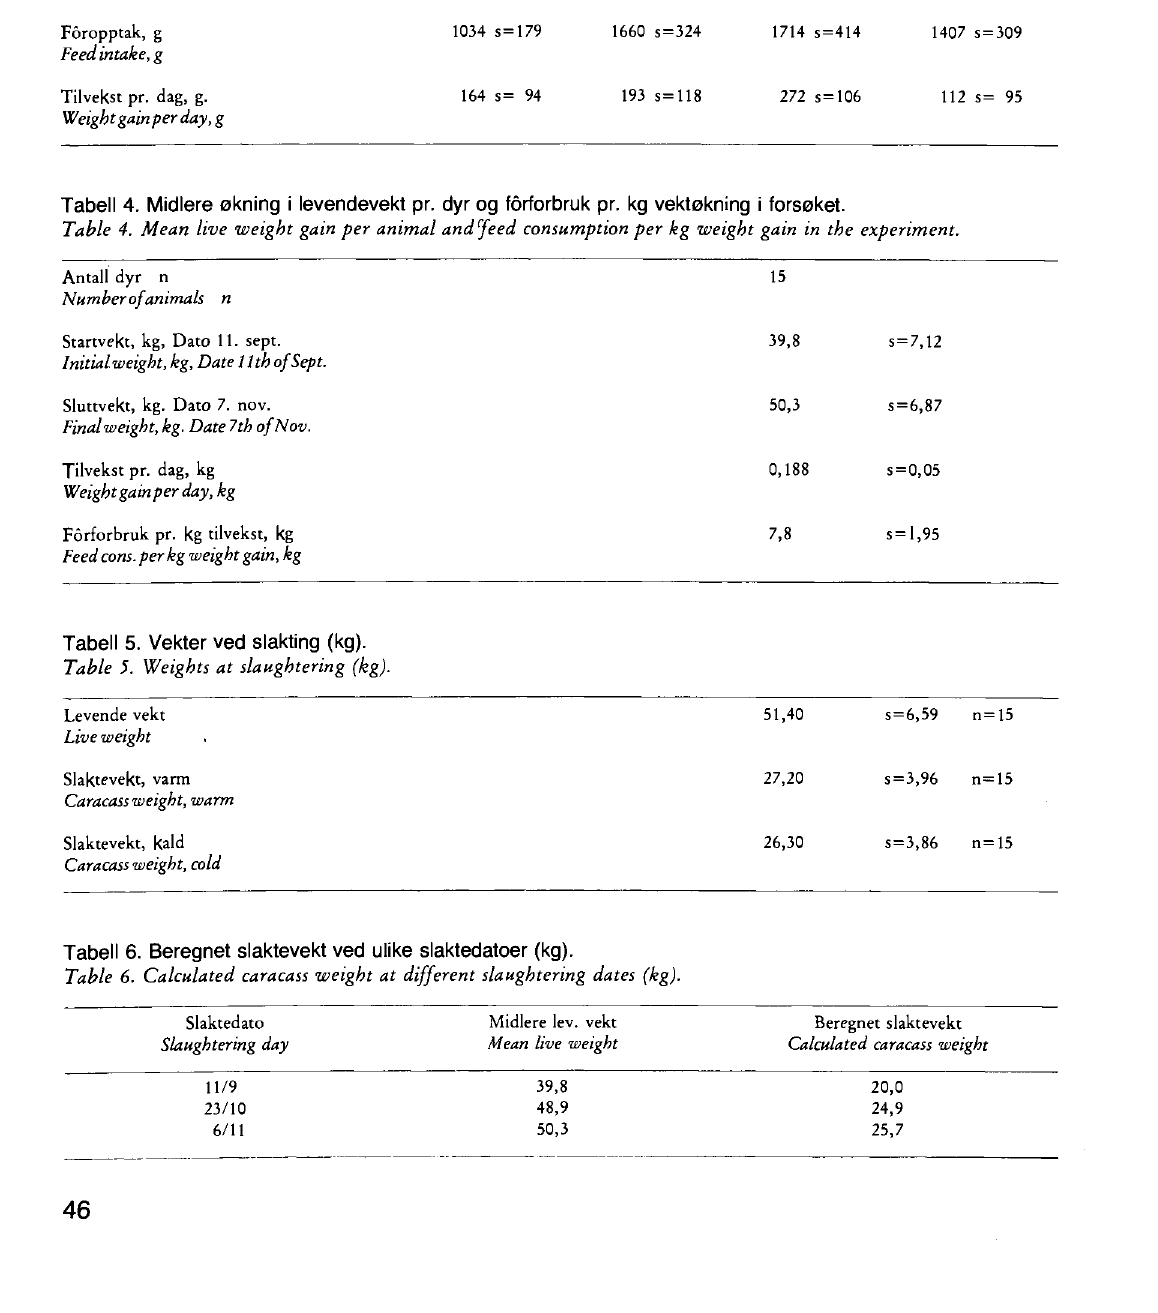
Antall dyr Number of animals Foropptak, g Feedintake, g